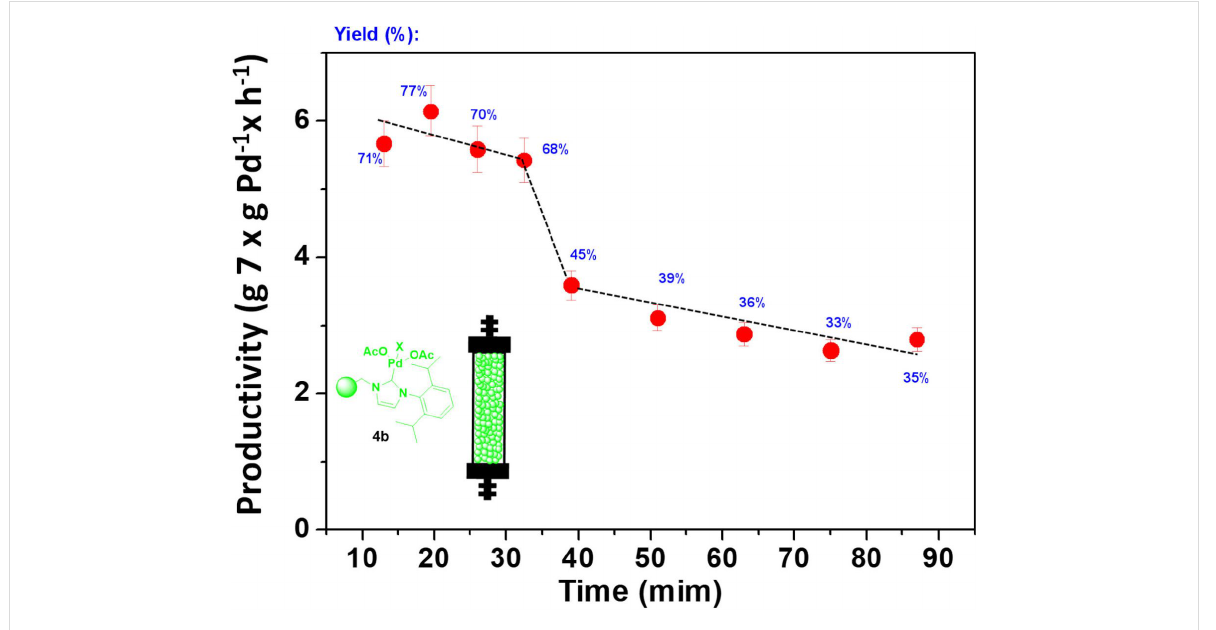
Figure 2: Negishi model reaction between 5 and 6 under flow conditions catalyzed by 4b . V = 0.535 mL, 363 mg of 4b , residence time = 2.5 min, total flow rate 0.214 mL/min. Productivity max: 7.97 g of 7 × g Pd − 1 × h − 1 . Yields calculated by GC and confirmed by 1 H